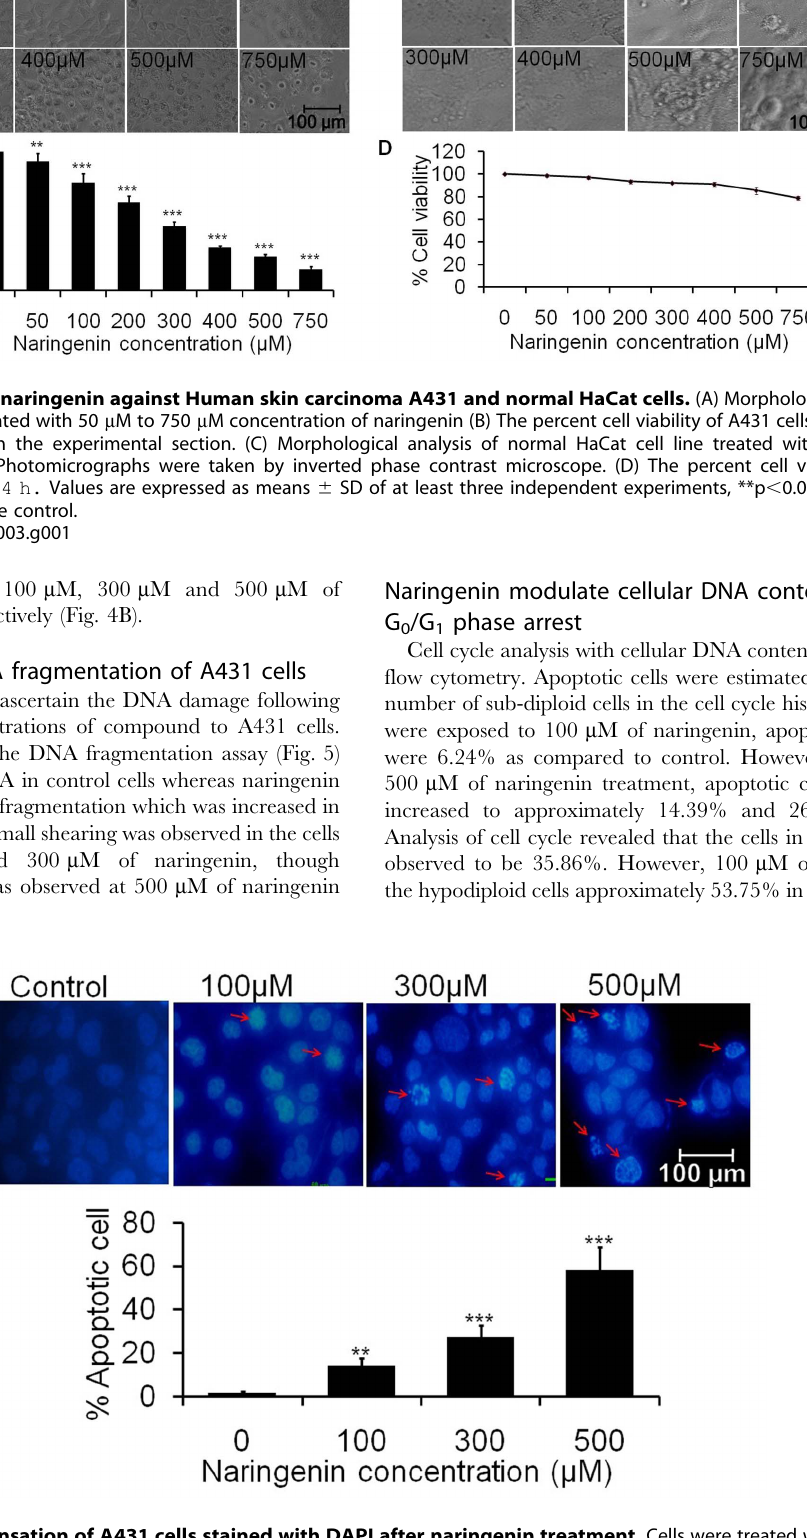
Figure 2. Chromatin condensation of A431 cells stained with DAPI after naringenin treatment. Cells were treated with 100 m M, 300 m M and 500 m M of naringenin. (A) Photomicrographs were taken by florescence phase contrast microscope that showed fragmented and condensed nuclei as indicated by arrow (B) Numerical data were expressed as % apoptotic cells respective to their control. Data is representative of three independent experiments and expressed as means 6 SD, **p , 0.01 and ***p , 0.001 as compared with their respective control.